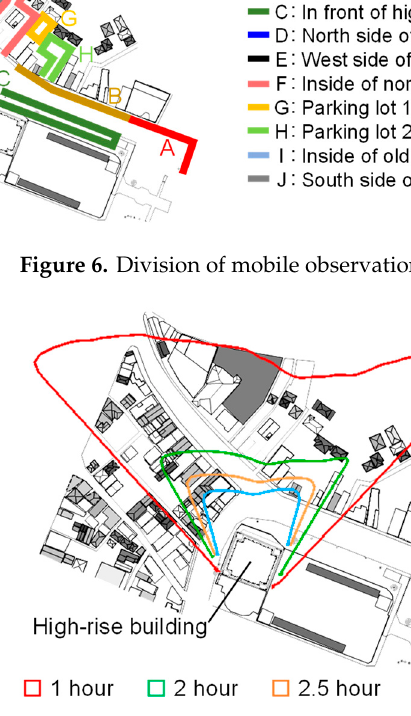
Figure 7. Shadow time diagram of the high-rise building for winter solstice.